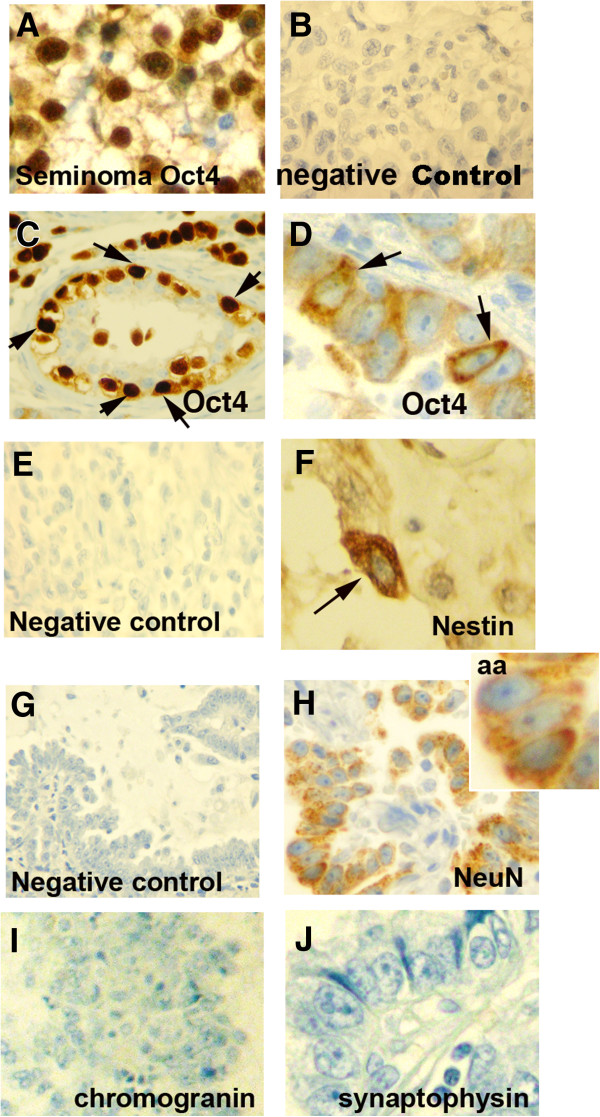
Immunohistochemical (IHC) staining for Oct4, Nestin, and NeuN in primary NSCLC. Shown are representative images. (B, E, G) Negative controls. Positive cells are stained brown. (A) Seminoma was used as positive control for Oct4. (C) shows nuclear staining in cancer cells for Oct4 and (D) shows cytoplasmic expression of Oct4. (F-H) Cancer cells expressing Nestin or NeuN expression. (aa) Magnified image of cells expressing NeuN. (I-J) Chromogranin and synaptophysin were not expressed in the NSCLC shown above.